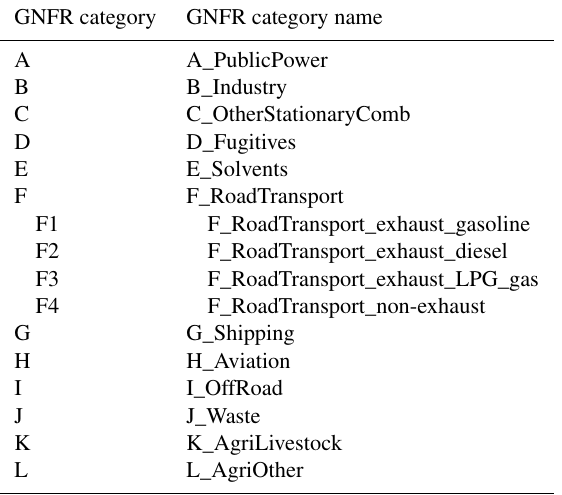
Table 2. Overview of aggregated NFR (GNFR) sectors distin- guished in the emission